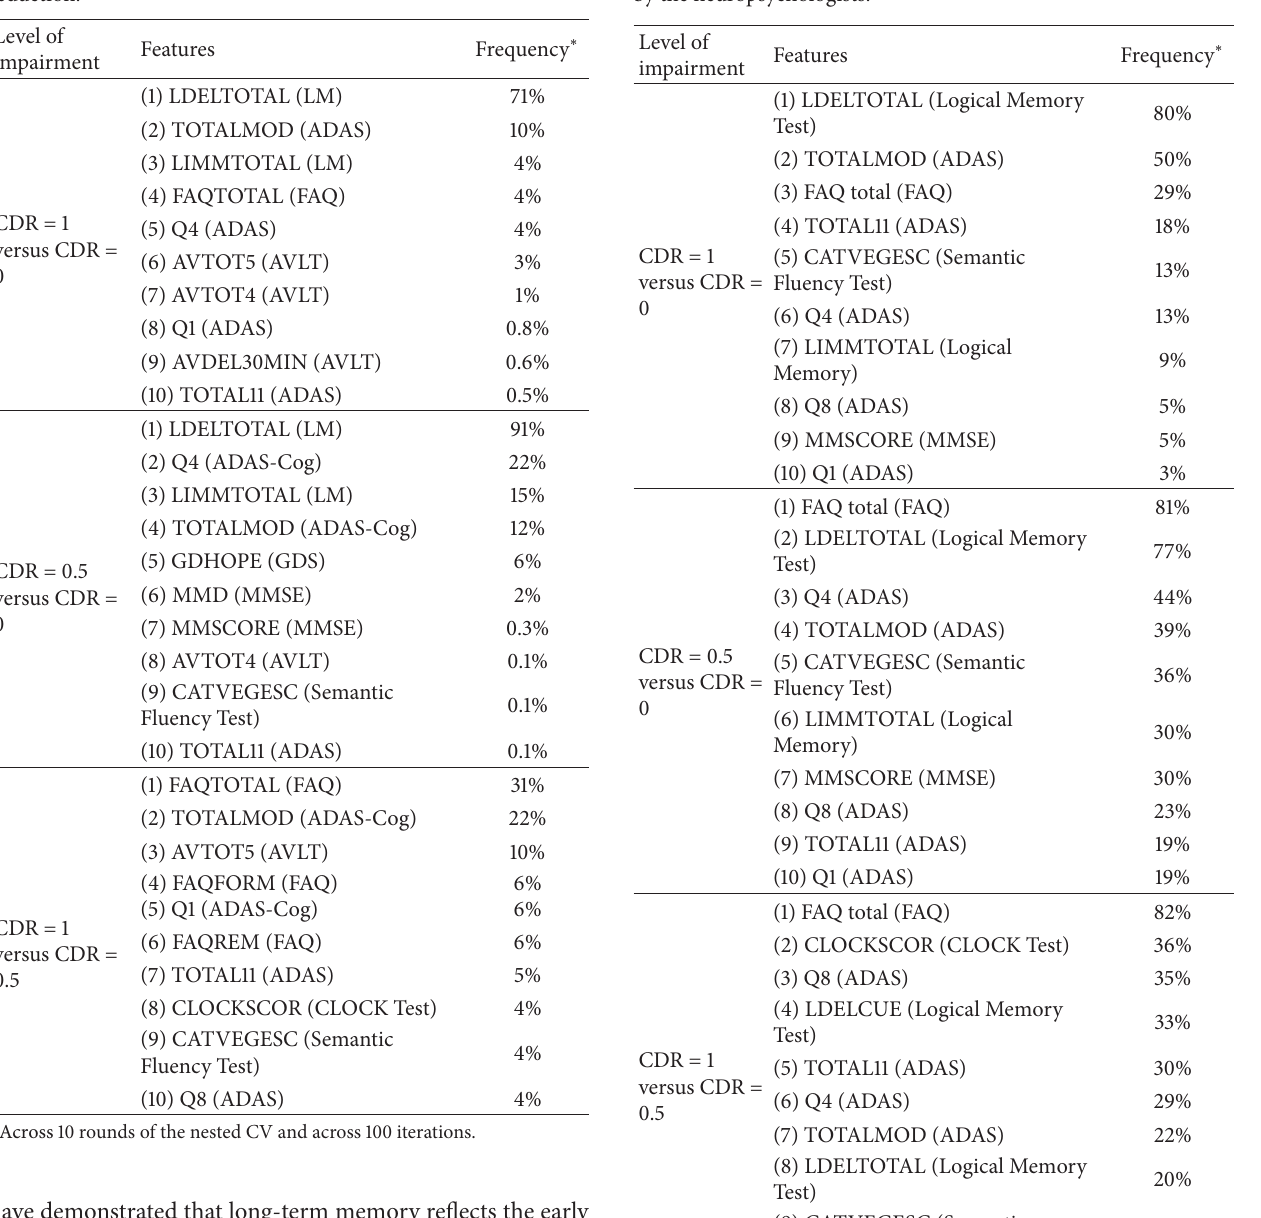
Table 9: Top 10 features most frequently found as best predictors across all 10 rounds and all 100 iterations using the FDR feature reduction.